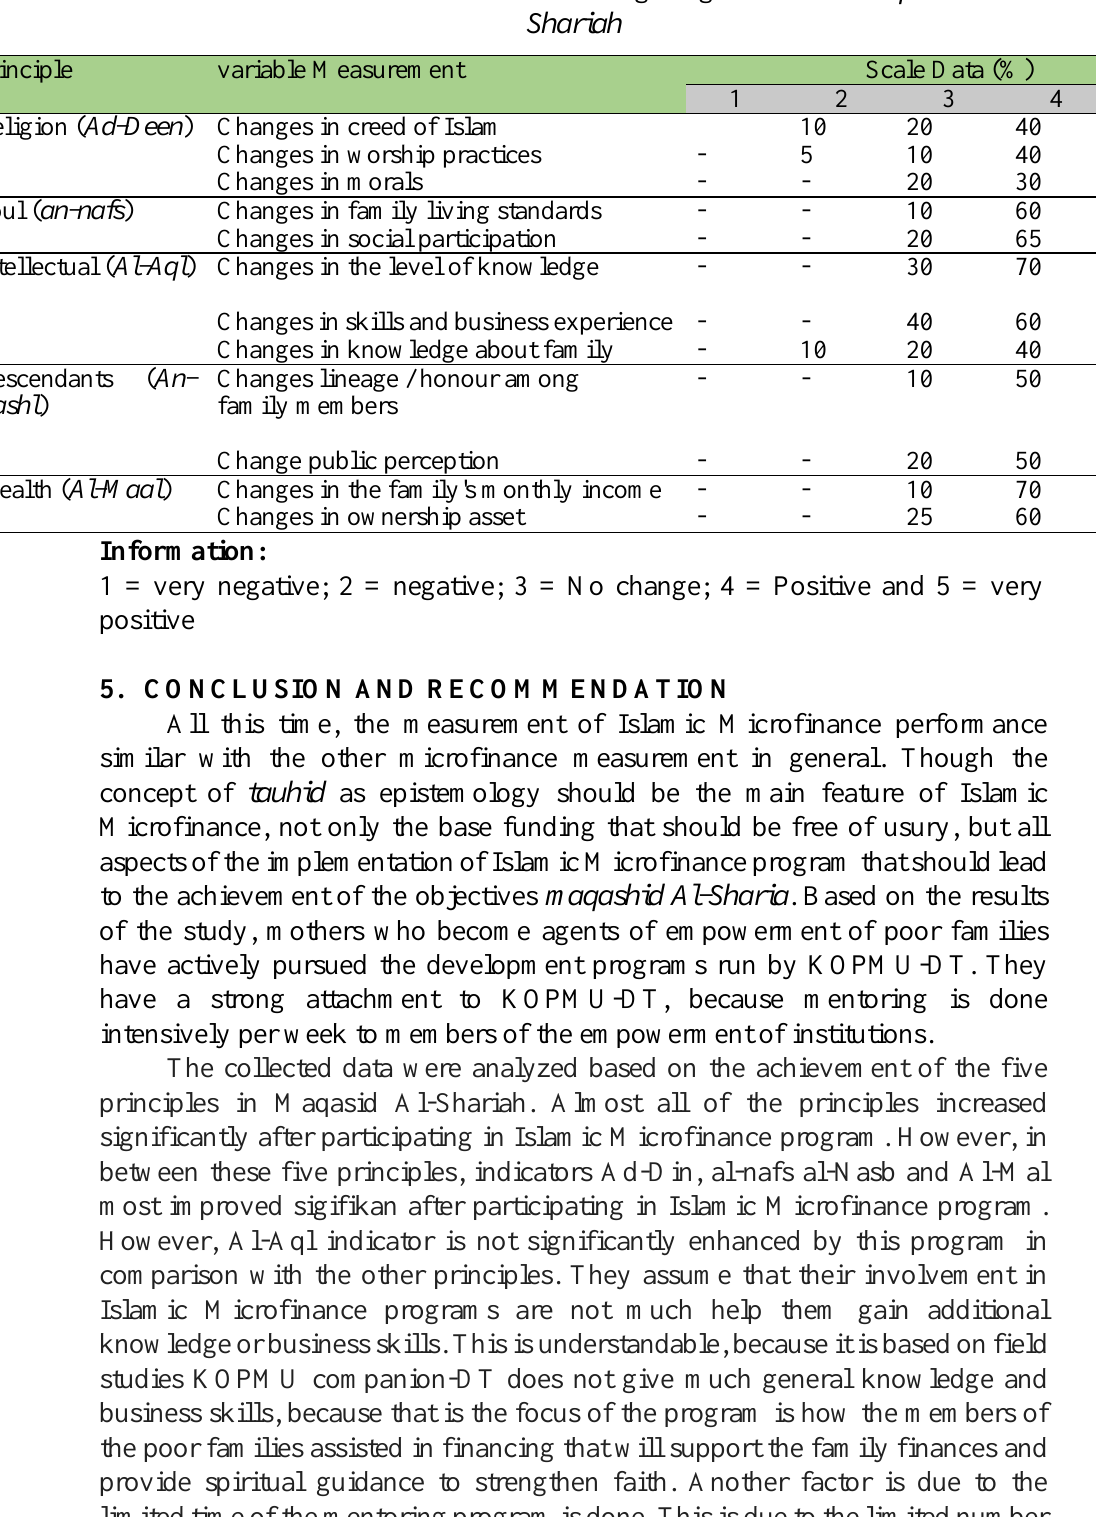
Table 4 Achievement of Micro Financing Program Based Maqashid